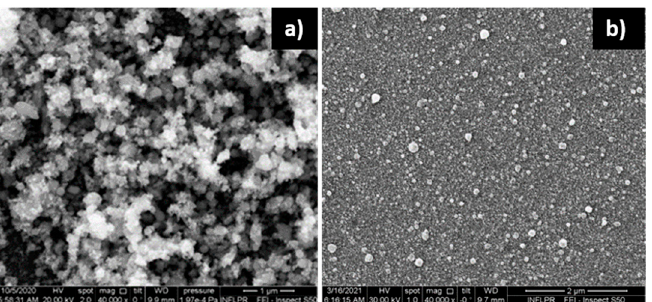
Figure 6. SEM images of ZnO films deposited in 700 mTorr O 2 and a wavelength of 532 nm using ( a ) a ps laser with 0.3 W operating at 10 kHz repetition rate; ( b ) a ns laser with 75 mJ/pulse operating at 10 Hz repetition rate.